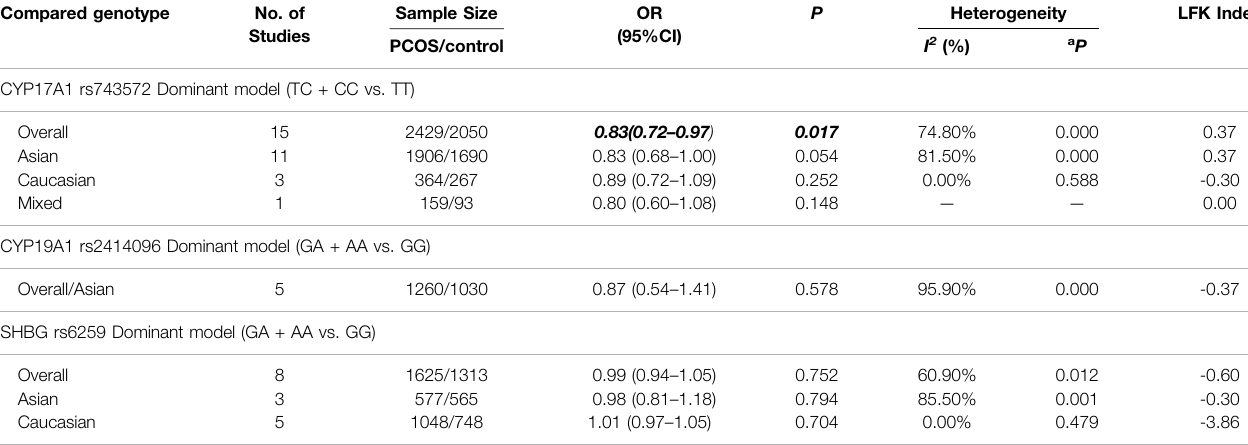
TABLE 2 | Meta-analysis of the association gene polymorphism and the polycystic ovary syndrome risk. Compared genotype